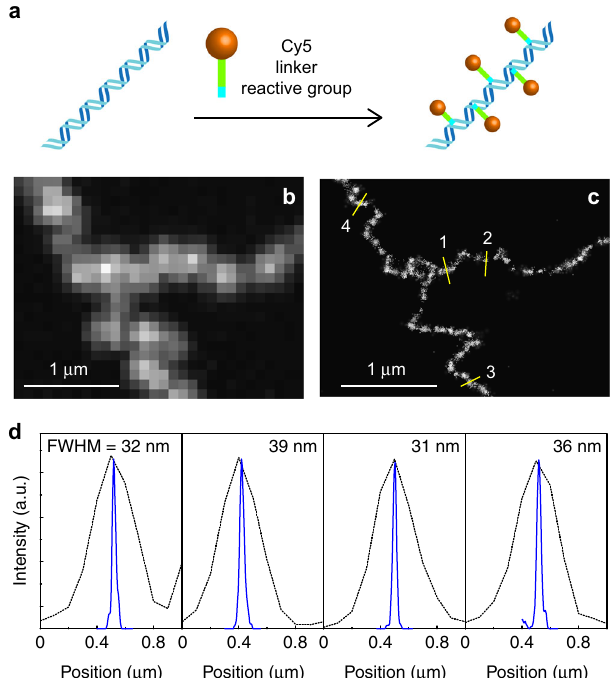
Fig. 1 Super-resolution fl uorescence imaging of DNA using covalently conjugated fl uorophores. a Schematic illustration describing covalent conjugation of dsDNA to Cy5 dyes. b Conventional fl uorescence image of Cy5-labelled lambda DNA deposited on a glass surface. c Super-resolution fl uorescence localisation microscopy image of the Cy5-conjugated DNA displayed in b . d Fluorescence intensity pro fi les obtained at four different positions of the molecule displayed in c . The dotted lines show fl uorescence intensity pro fi les obtained from the conventional fl uorescence image displayed in